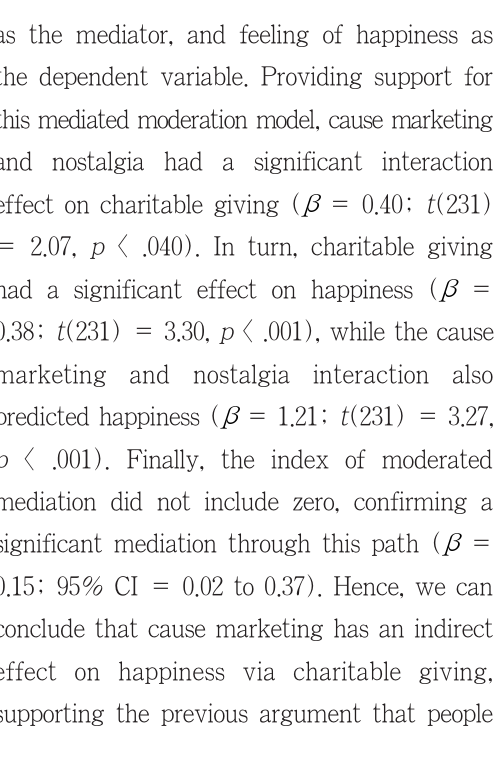
<Figure 4> The path model for cause marketing, nostalgia, charitable giving, and happiness